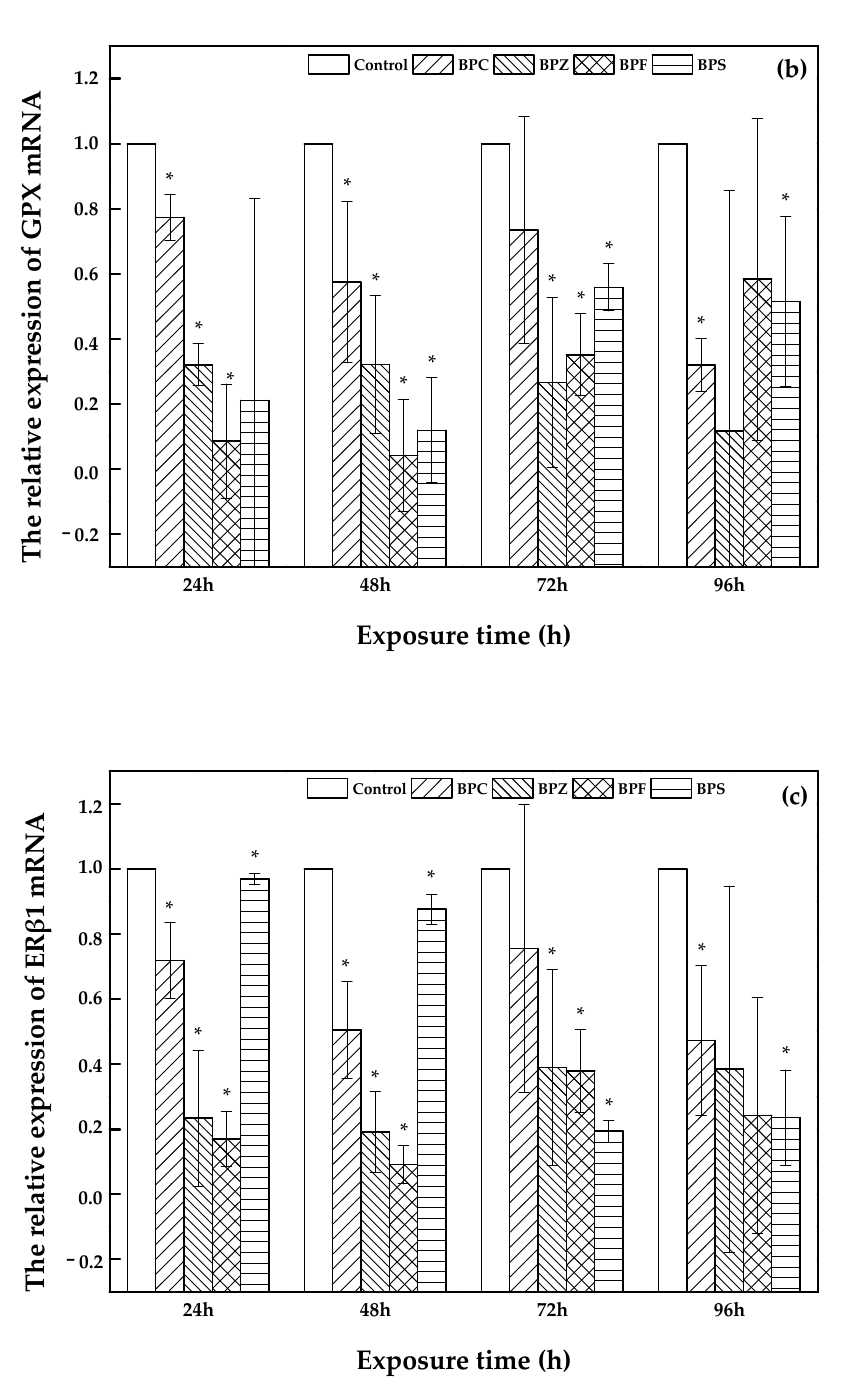
Figure 4. Relative expression of CAT ( a ), GPX ( b ), and ER β 1 ( c ) in treated and control groups (values represent mean ± S.D.; sample size: 3; * significant difference compared to the blank control ( p < 0.05)).